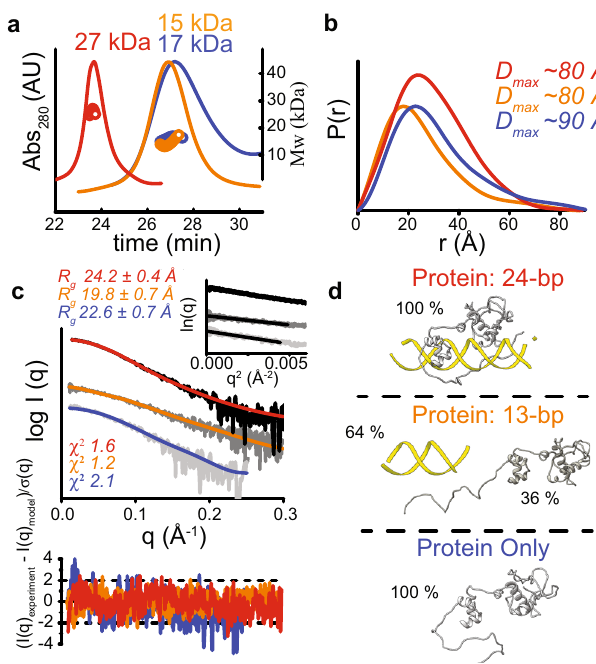
Fig. 2 SAXS analysis of the repressor on and off DNA. a SEC elution pro fi les for the repressor only (blue), repressor mixed with a 13-bp DNA (orange), and repressor mixed with a 24-bp DNA (red), along with masses calculated from MALS. The masses con fi rm that the repressor is a monomer in solution both on and off DNA. b P ( r ) functions calculated from the experimental data that is shown in panel c , with the traces color-coded as in a . The distance r , in Angstroms (Å), on the x -axis where the P ( r ) function approaches zero intensity represents the maximal dimension ( D max ) for each sample. c Experimental SAXS curves are shown in gray/ black along with the theoretical scattering pro fi les, fi t-residuals, and χ 2 values for the atomistic models of the protein:24-bp DNA (red trace), protein:13-bp DNA (orange trace), and protein only (blue trace) samples shown in panel d . The Guinier plots (inset) were used to calculate the radius of gyration values ( R g ) for each sample. d Atomistic models derived from SAXS- fi tting, with protein colored in gray and DNA in yellow. The percentages de fi ne how much each model contributes to the theoretical scattering pro fi les shown in panel c . Top panel: the protein:24-mer complex provides an excellent fi t to the experimental data ( χ 2 = 1.6), con fi rming that the structure observed in the crystal matches the conformation of the complex in solution. The long loop at the N-terminus represents the fi rst 14 residues of the protein as well as the His-tag that was disordered in the crystal structure. Middle panel: the protein:13-bp sample is best described by a mixture of free protein and free DNA in solution, in agreement with the SEC trace in panel a . Bottom panel: The free protein matches the SAXS data when it contains solvent-exposed N- and ( η 1) at its N-terminus that contributes to DNA recognition in a manner similar to homeodomain proteins 21 .